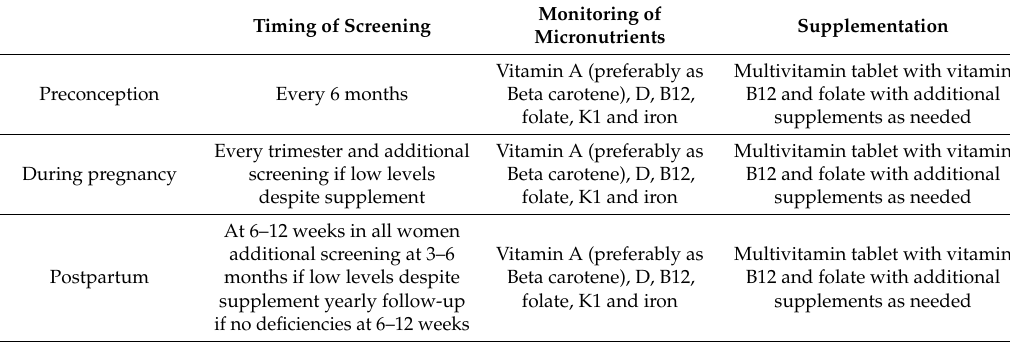
Table 3. Proposal of micronutrient monitoring and supplementation from preconception to postpartum in women after bariatric